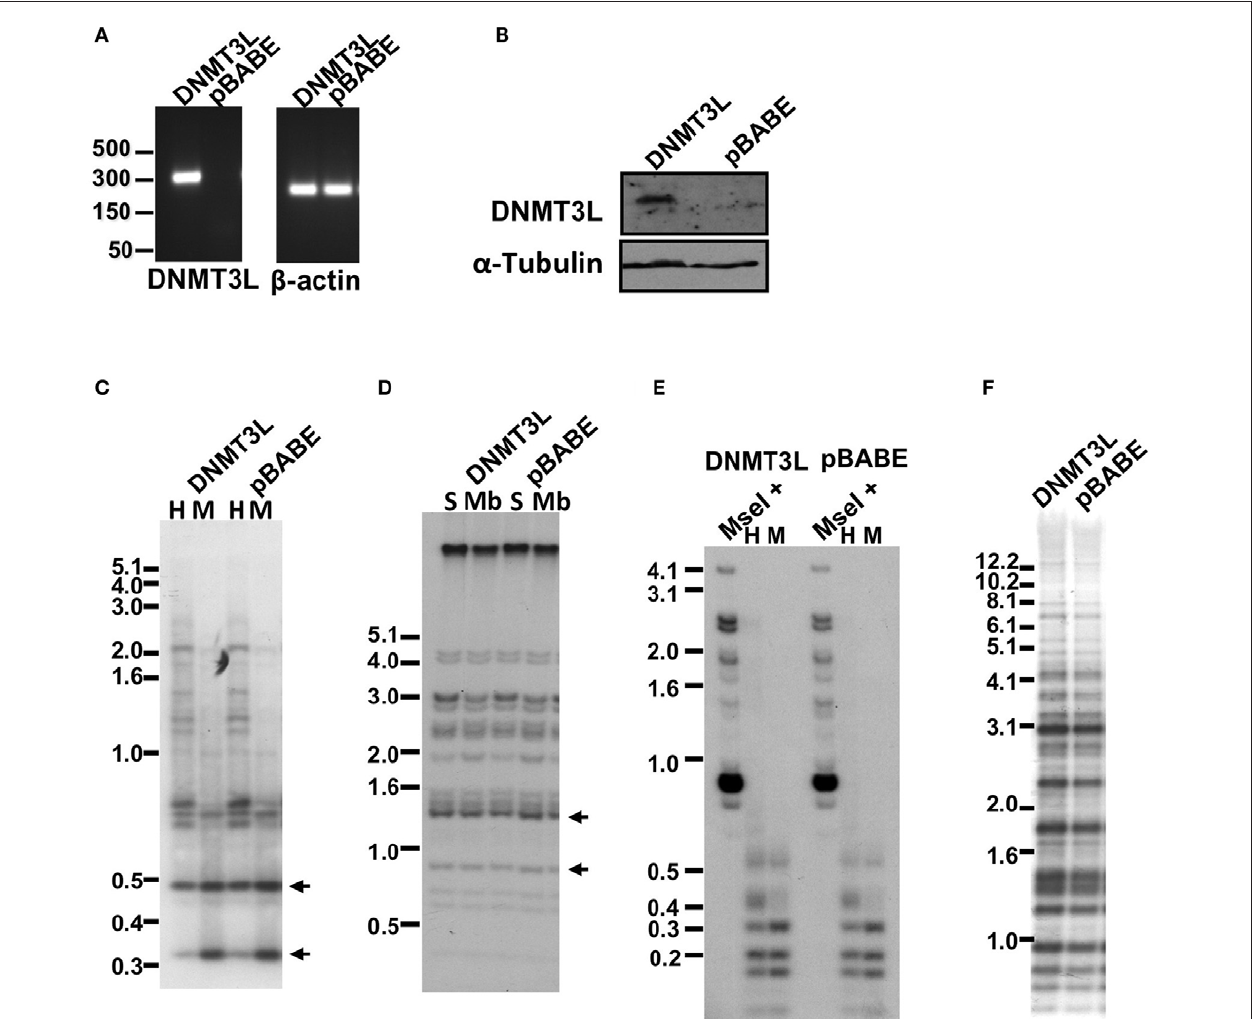
FIGURE 8 | Methylation of subtelomeric regions and other non-telomeric repetitive sequences, as determined by Southern analysis, following co-expression of human DNMT3B1 and DNMT3L in ICF fibroblasts. (A) RT-PCR analysis of DNMT3L mRNA expression in pCor + hTERT + DNMT3B1 fibroblasts introduced with either DNMT3L (DNMT3L) or with an empty plasmid (pBABE) (left panel). Size markers in kb appear to the left of the blot. β -actin was amplified as a control (right panel). (B) Western blot analysis of DNMT3L expression in pCor + hTERT